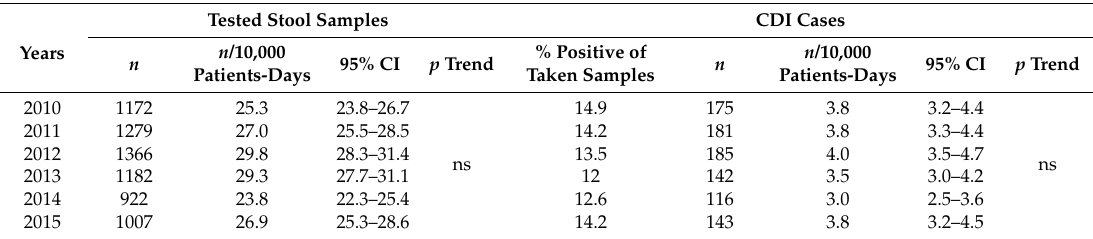
Table 1. Stool samples tested (numbers and incidence rates) and Clostridium difficile infection (CDI) cases (numbers and incidence rates) per 10,000 patients-days, per year.